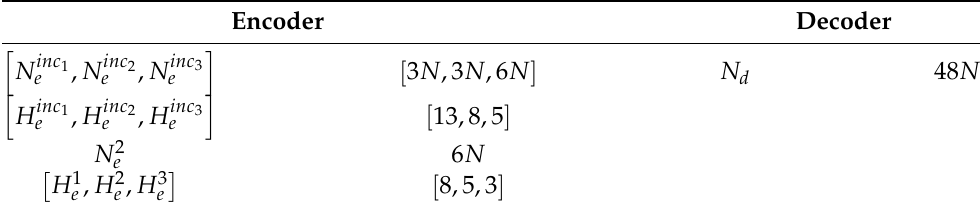
Table 3. Two-storey shear building model: AE